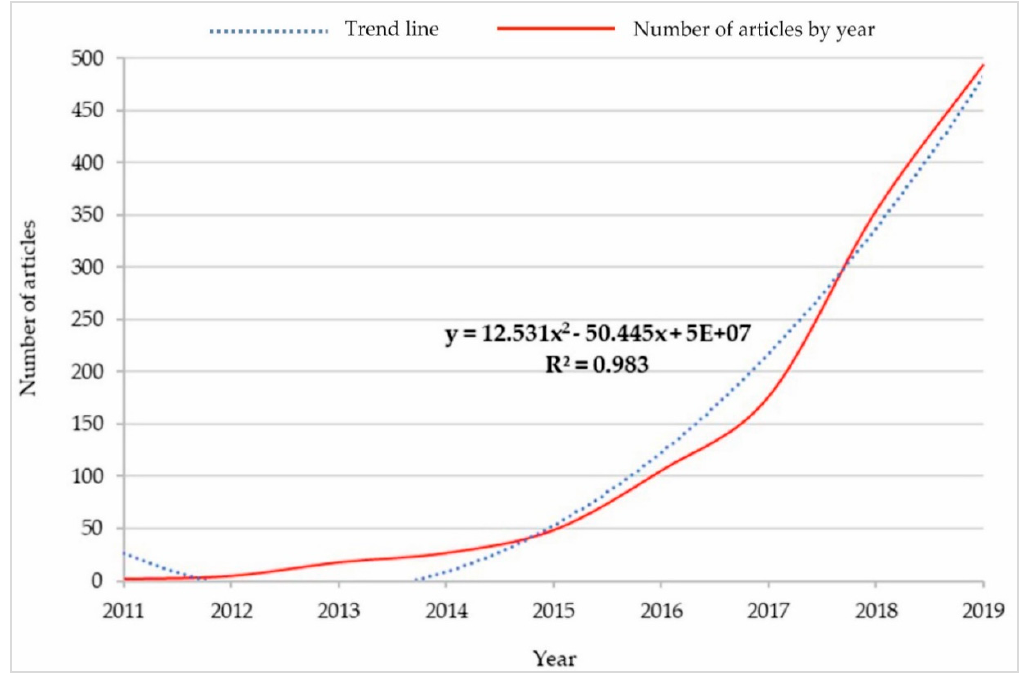
Figure 2. Evolution of scientific production (2011–2019).